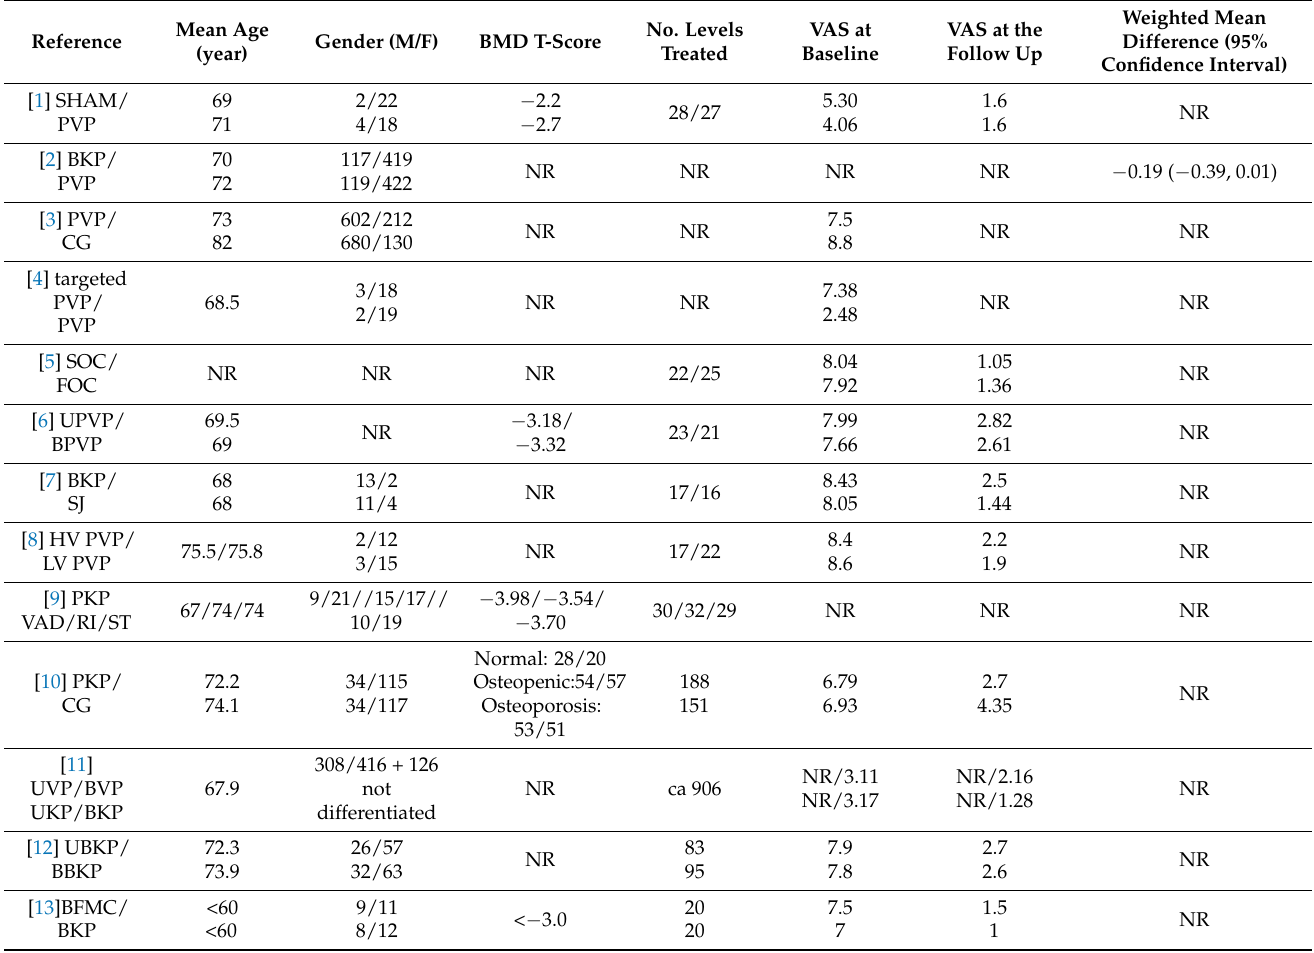
Table 2. Demographics and preoperative characteristics.